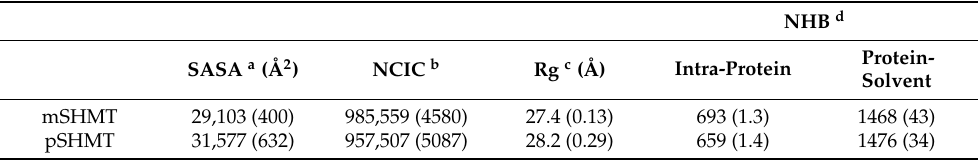
Table 1. Average values and SDs (in parentheses) of structural/geometrical parameters calculated from the single joined equilibrium MD trajectories of mSHMT and